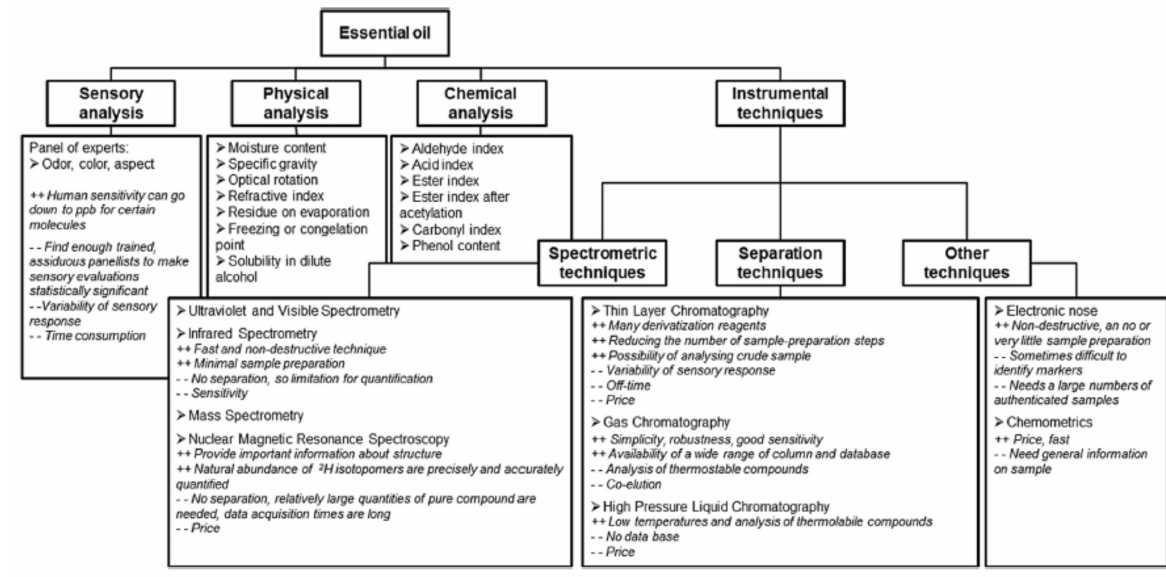
Figure 2. Summary of the existing quality assessment methods of EOs, regarding major advantages (++) and disadvantages (–) (reprinted from [30] with permission from